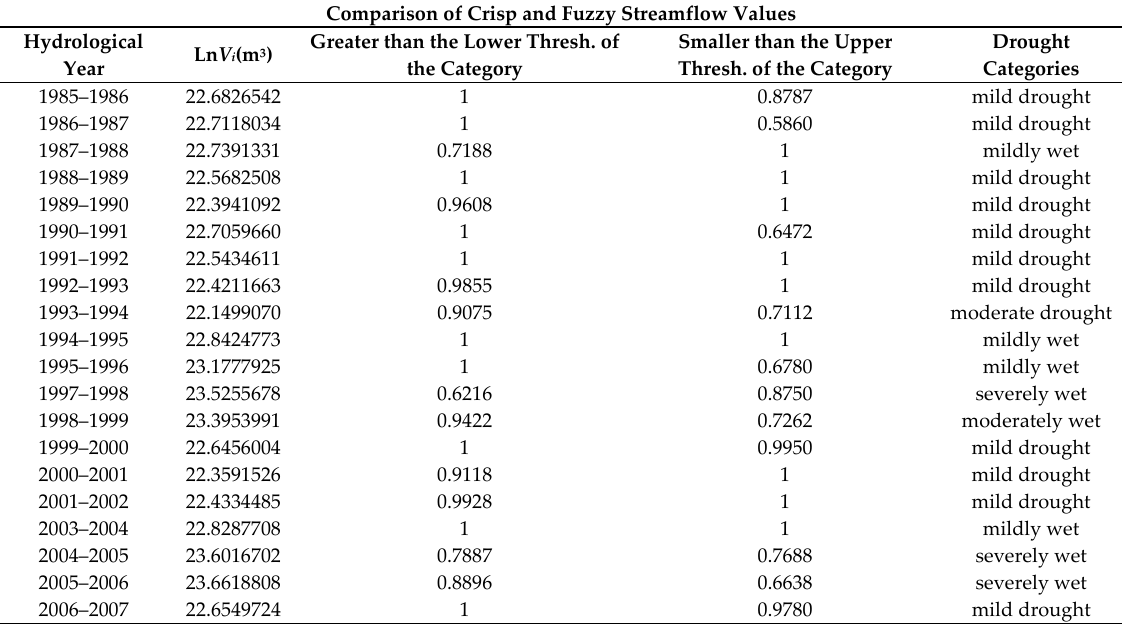
Table 2. Drought classification based on the fuzzy measure G i , k and S i , k. Comparison of Crisp and Fuzzy Streamflow